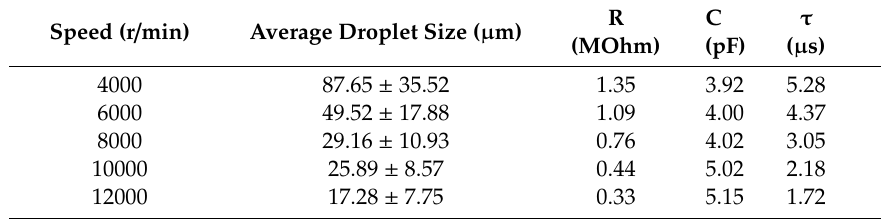
Table 2. Equivalent circuit fitting electrical value of Pickering emulsions with di ff erent droplet